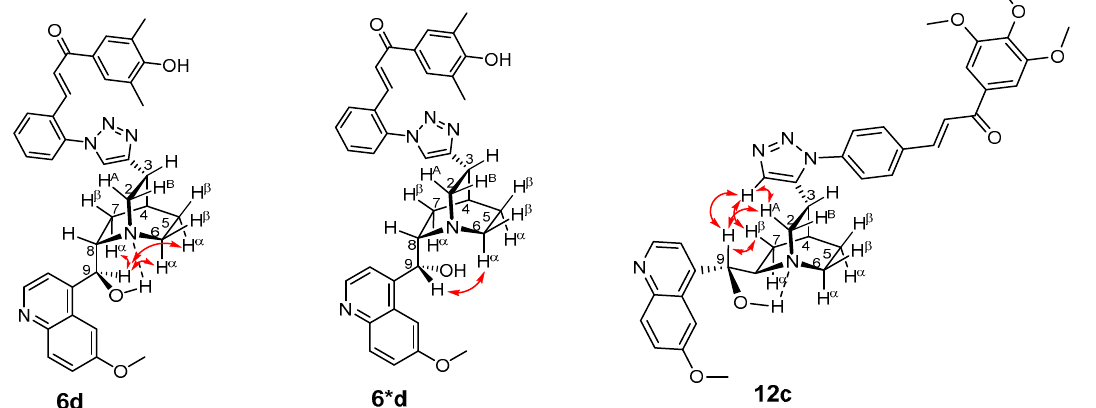
Table 3. List of cinchona-chalcone hybrids with 1,5-disubstituted-1,2,3-triazole linker and yields.